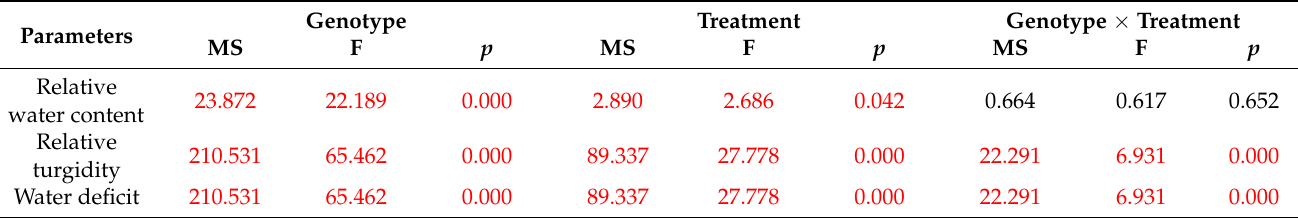
Figure 3. Treatment with bikinin resulted in phenotypic changes in barley grown under normal and salt stress conditions. Relative water content ( a ), relative turgidity ( b ), and water deficit ( c ) after treatment with 10 µ M, 50 µ M, and 100 µ M bikinin (BK10, BK50, and BK100, respectively), compared to controls with 0.11% DMSO (CK), used as background for solvent solutions for each bikinin concentration. Non-treated plants were used as a control for the 0.11% DMSO treatment. The values in ( a – c ) represent the mean and standard error for six biological replicates. The results of the HSD Tukey test analysis are presented in Table S2 (*, p ≤ 0.05; **, p ≤ 0.01; ***, p ≤ 0.001). Table 4. Results of two-way ANOVA for two barley genotypes (Golden Promise and Haruna Nijo) grown under salt stress (150 mM sodium chloride) after bikinin treatment (non-treated; treated with 0.11% DMSO; and treated with 10 µ M, 50 µ M, and 100 µ M bikinin dissolved in 0.11% DMSO) were calculated for the 3rd leaf (length; FW, fresh weight; DW, dry weight; area). MS–mean square; F–F-test; p–p-value ; red characters–significant